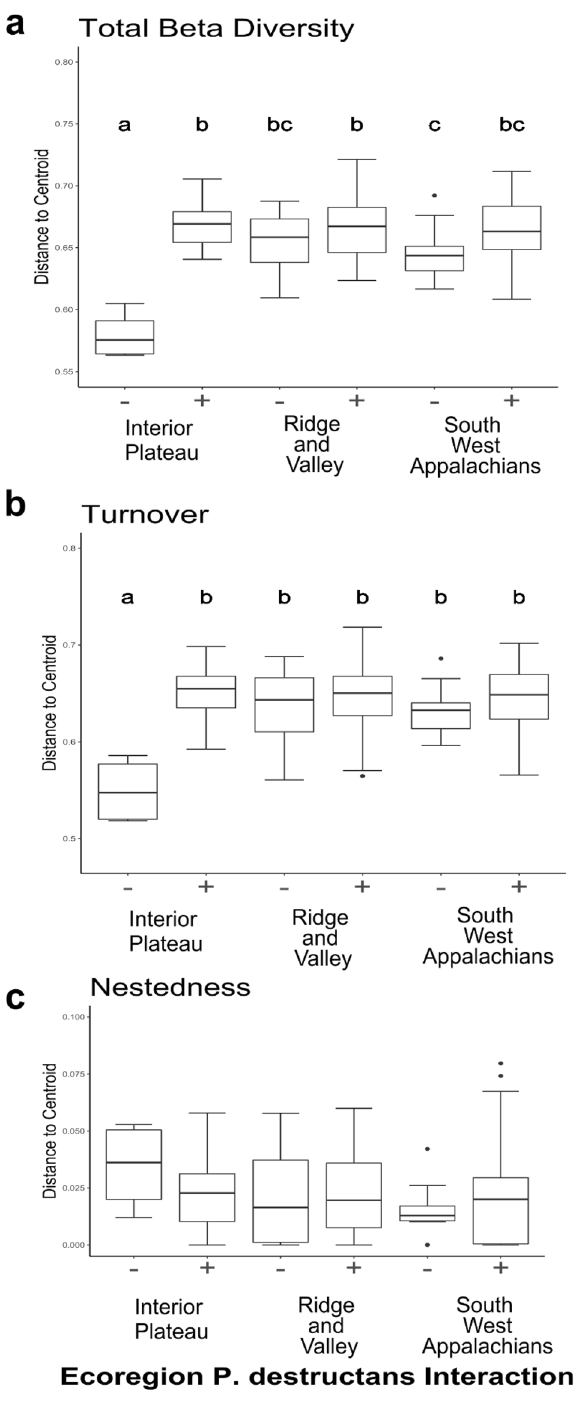
Figure 5. Betadisper analysis comparing beta diversity measured as multivariate dispersion across the interaction of ecoregion and P. destructans status, for ( a ) total beta diversity (SOR), ( b ) turnover (SIM), and ( c ) nestedness (SNE). Different lowercase letters indicate a significant difference ( p ≤ 0.05) between groups, lowercase letters are missing from panel ( c ) due to lack of significant differences between groups. There is a significant interaction between P. destructans status and ecoregion for both total beta diversity as well as turnover (SOR: F 5, 243 = 15.232, p ≤ 0.05; SIM: F 5,243 = 8.646, p ≤ 0.05). Graphs were produced using the ggplot2 package (version 3.3.2) in R 25